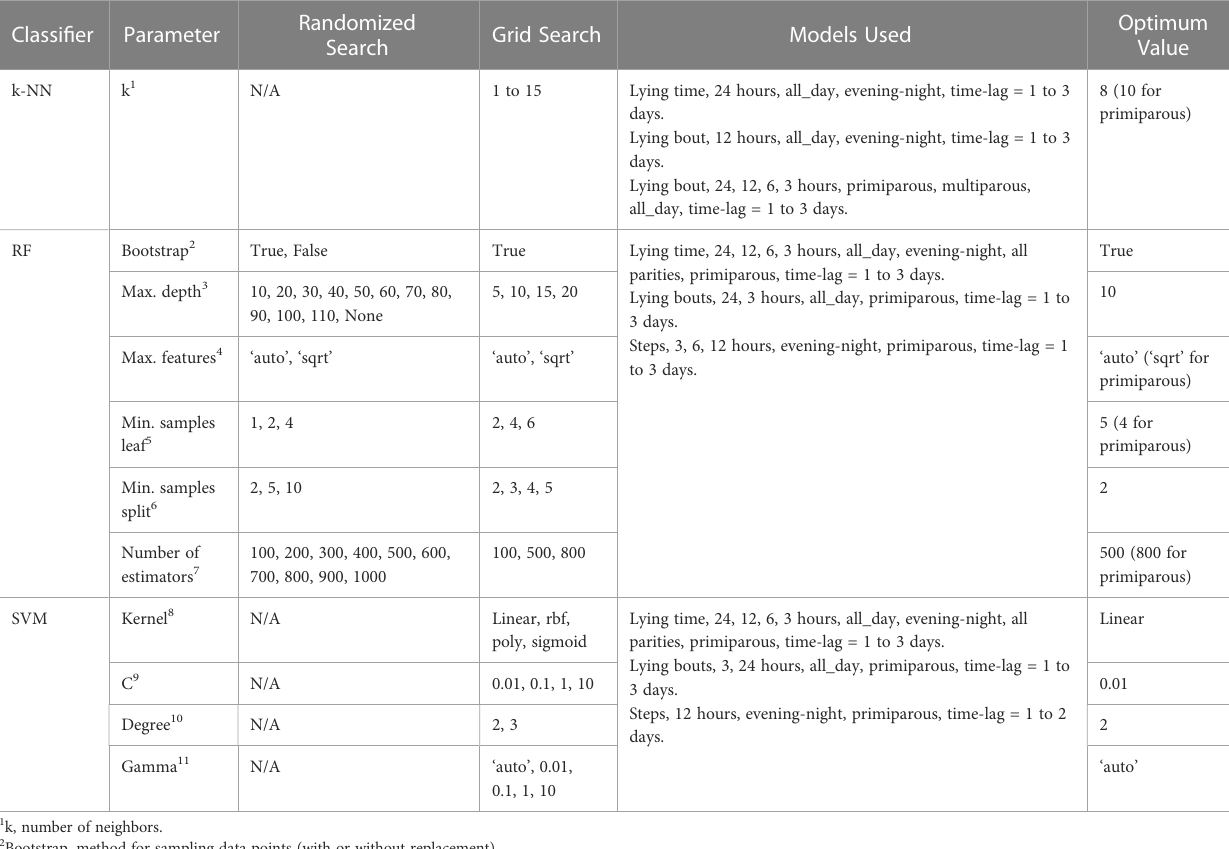
TABLE 1 Hyperparameter values used for optimization of k -nearest neighbors ( k -NN), random forest (RF), and support vector machine (SVM) classi fi cation algorithms used on behavior variables measured with a leg-attached 3-axis accelerometer (Trackacow, ENGS, Hampshire,